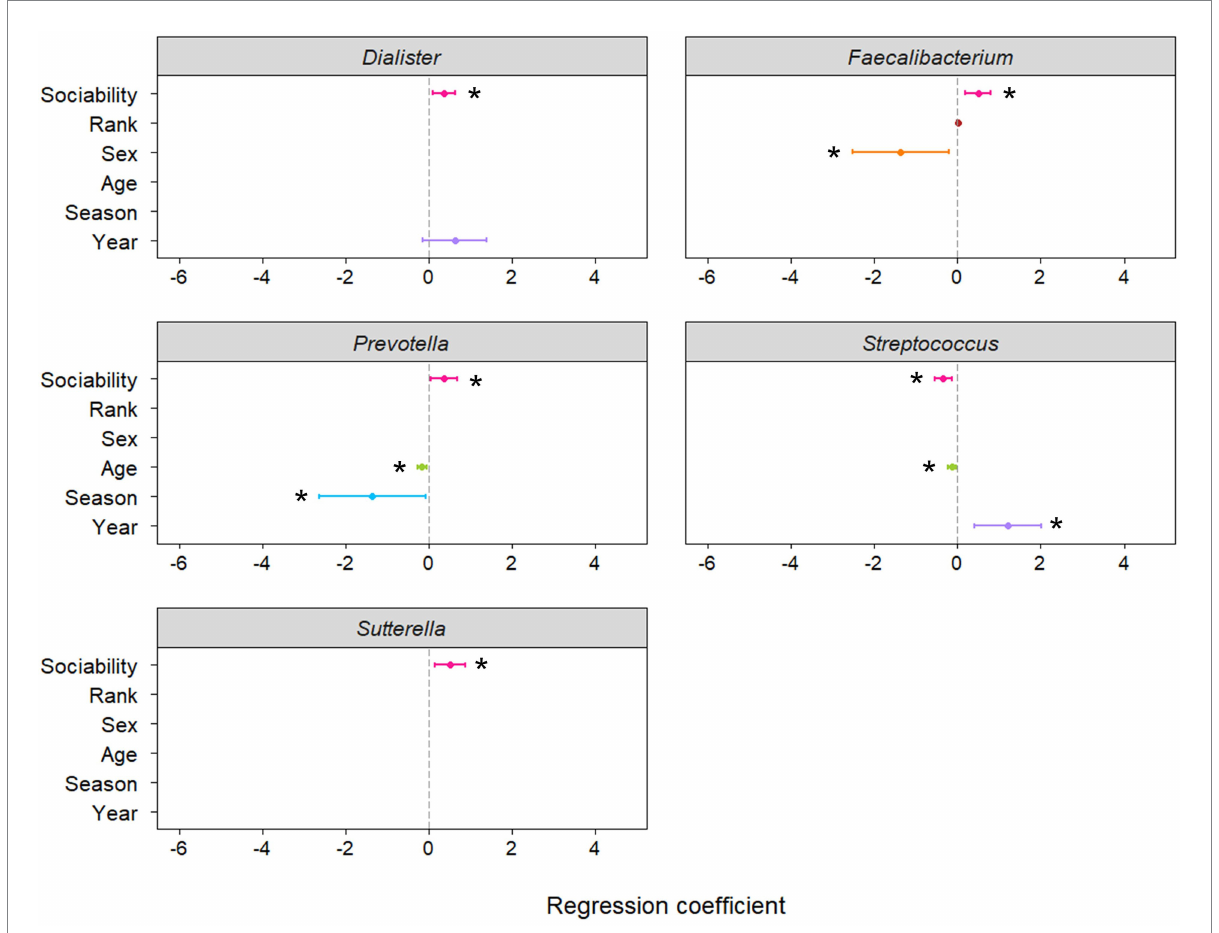
FIGURE 1 Coefficient plots from regression models predicting abundance of genera in the macaque gut microbiome. Asterisks denote significant predictors of genus abundance at α = 0.05 and bars indicate 95% confidence intervals. The main variable of interest was the sociability index (as measured by the number of grooming partners and duration of grooming interactions), whilst other variables were controlled for where appropriate, as determined using Akaike information criterion. A positive coefficient for sex indicates a higher abundance of the genus in females and a positive coefficient for season indicates a higher abundance of the genus during the mating season than the birthing season. Plots displayed here depict genera whose abundance was significantly related to sociability (for remaining regression coefficient plots see Supplementary Figure